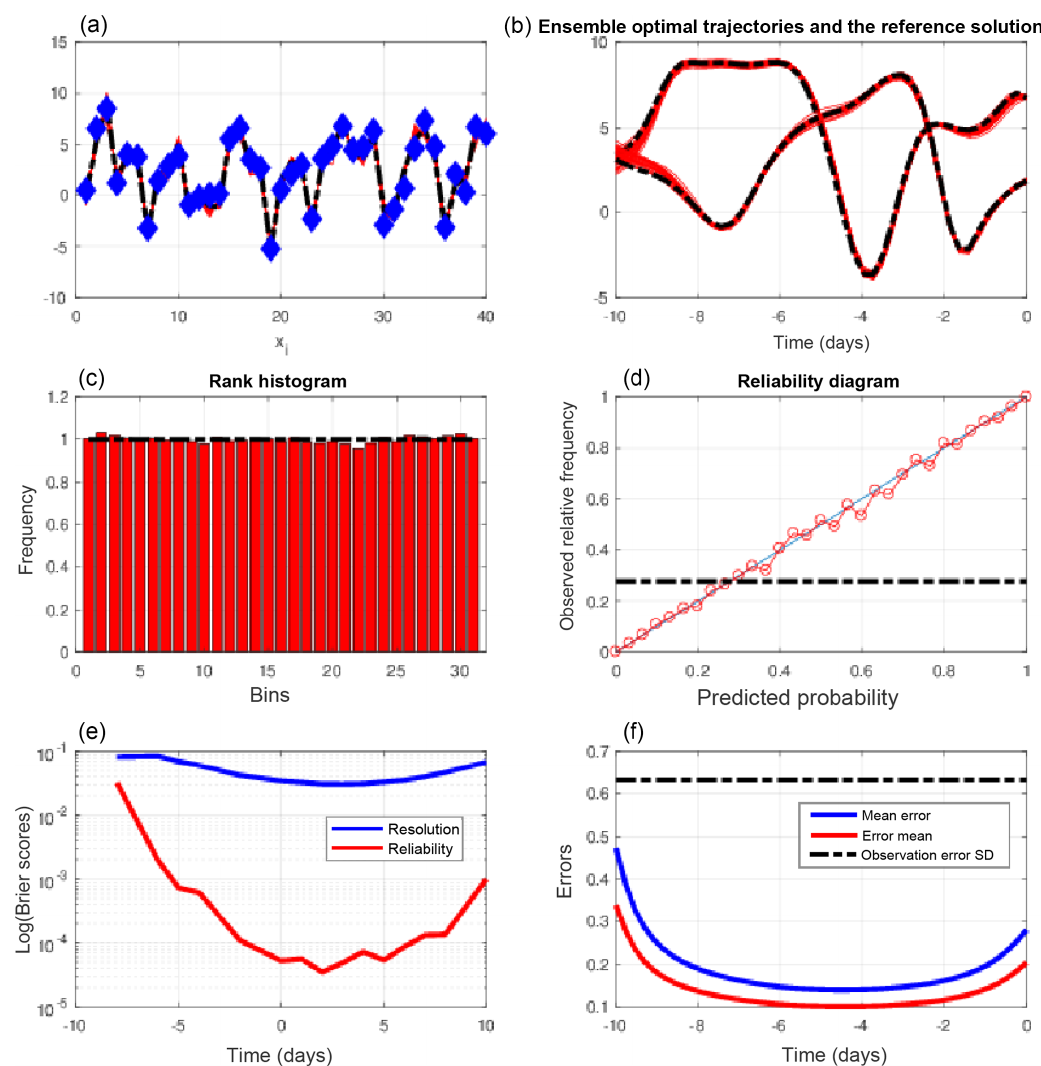
Figure 3. Same as Fig. 1, for quasi-static variational assimilations, with an increase in the length of the successive assimilation windows by 1 day. All scores are computed for the ensembles obtained from the final minimizations performed over the whole 10-day assimilation windows. The reliability diagram is relative to the event E = { x < 0 . 94 } , which occurs with frequency 0.29 (dashed–dotted horizontal